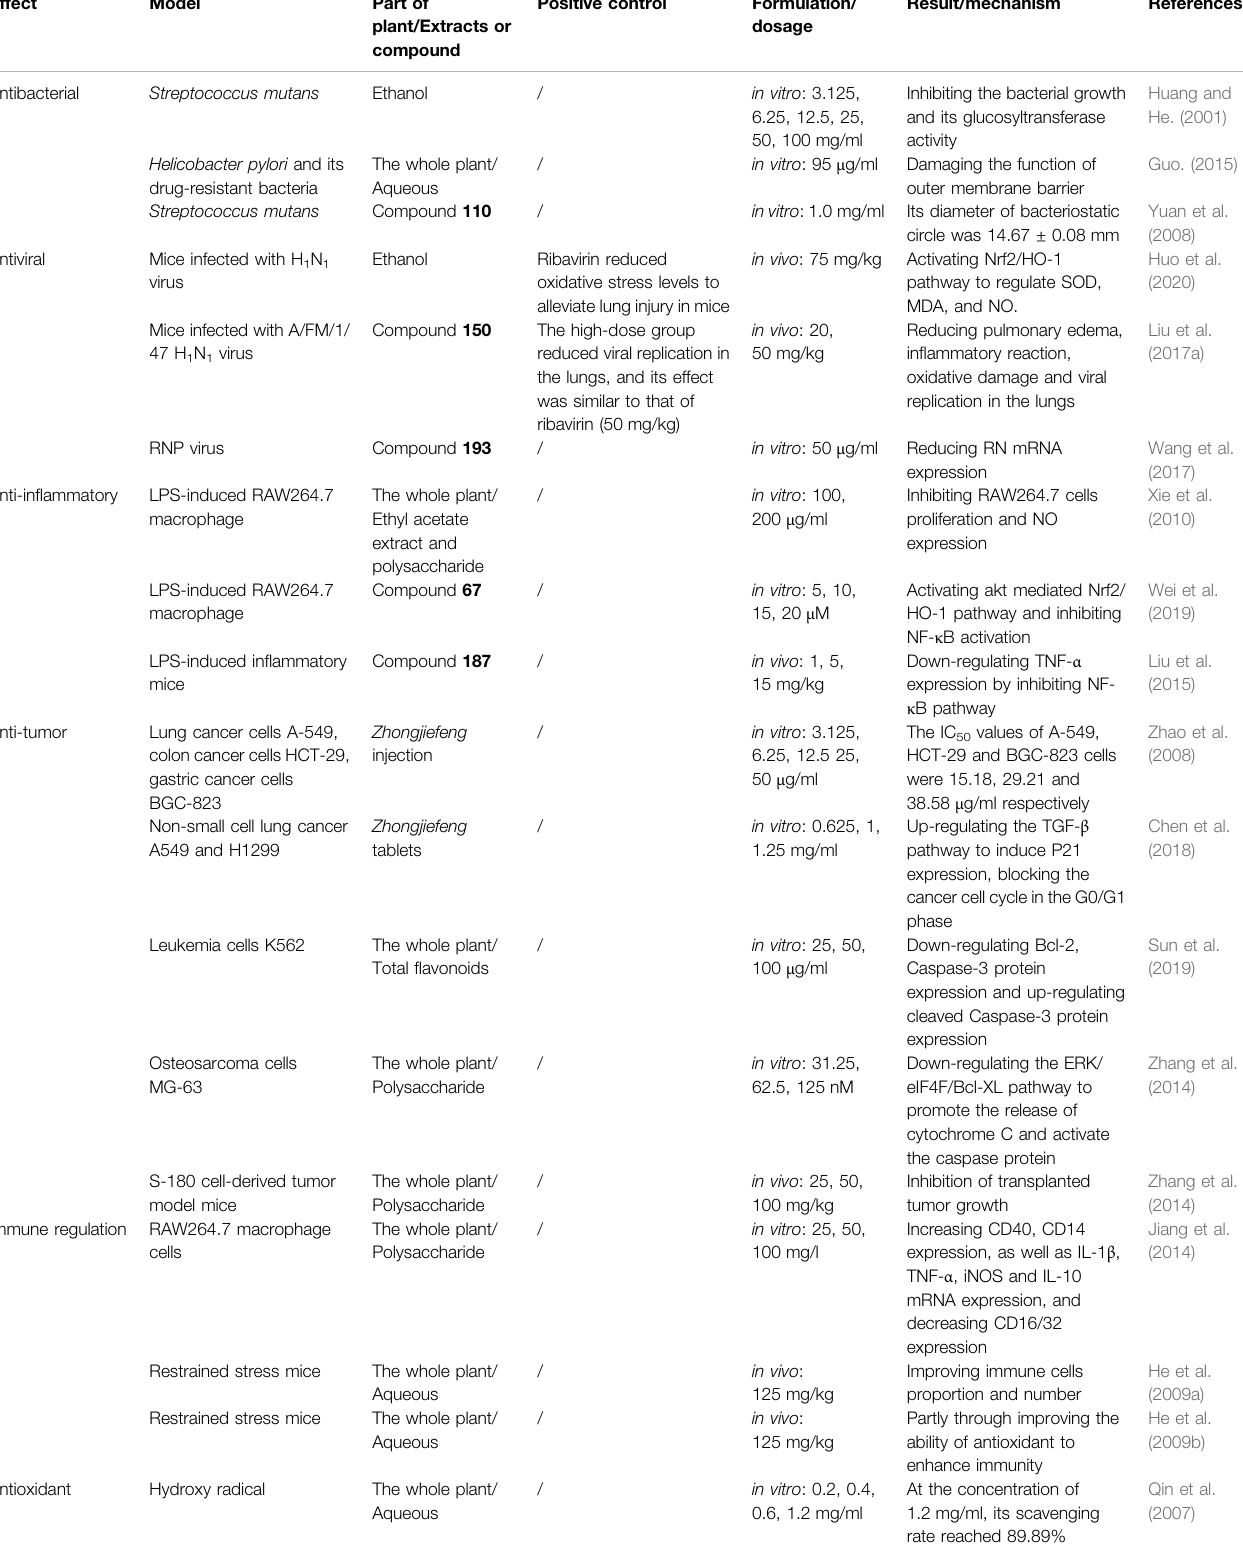
TABLE 2 | Modern Pharmacological studies of S. glabra